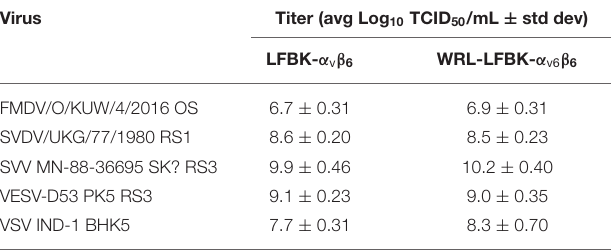
Values represent the average titer (n = 3) ± standard deviation; there were no significant differences between the two cell lines for each of the viruses tested (p-values > 0.05). OS, original epithelial suspension; cell line abbreviation and passage number: RS, IB-RS- 2 cells; BHK, baby hamster kidney cells; PK, pig kidney cells; SK, swine testis cells and